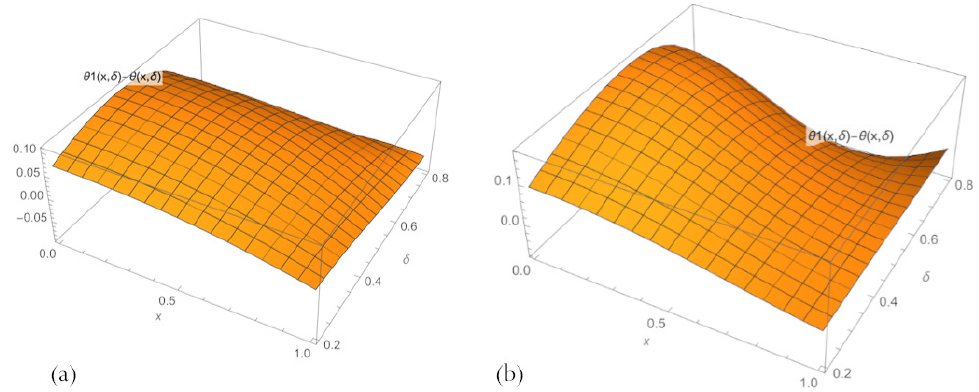
Figure 3. Errors in the multilayer solutions (20) with an embedded neural network (17) to problem (11), across parameter space 0.2 < δ < 0.8, for ( a ) n = 3 and ( b ) n =